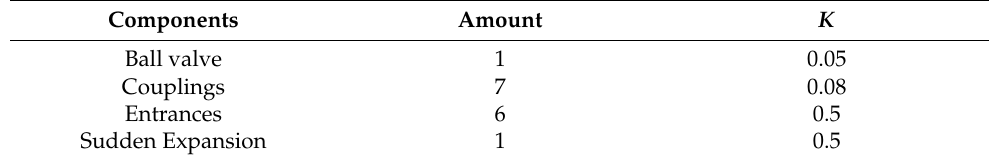
Table 2. In this table, we list of possible minor loss components to be included in the